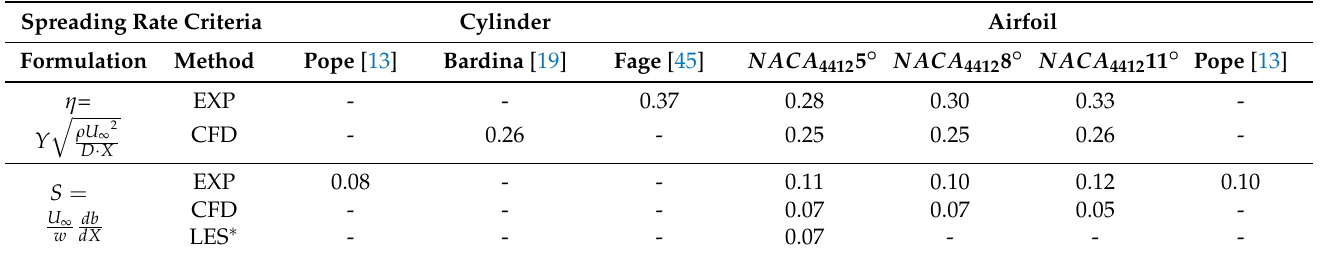
Figure 16 i.e., the streamwise spreading of the wake. The S parameter does not correlate with the AOA. The EXP data are in agreement with the reported S in the literature both for the airfoil and the cylinder. The confinement effect on self-similarity is negligible since the LES ∗ data are in agreement with the CFD data. Table 4. Spreading rate: different formulations, η and S , and different test cases. The D in η